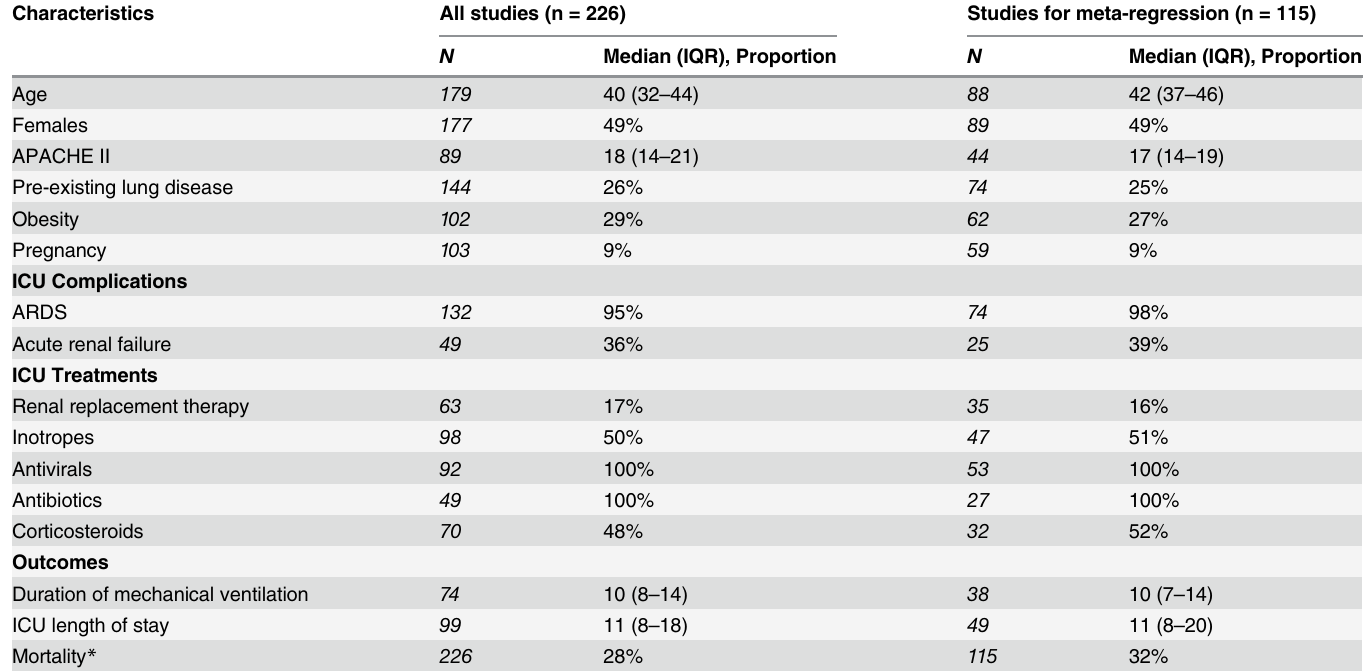
Table 2. Description of patient characteristics, intensive care specific interventions and outcomes from included studies compared to the studies selected for the meta-regression respectively. Characteristics All studies (n = 226) Studies for meta-regression (n = 115) N Median (IQR), Proportion